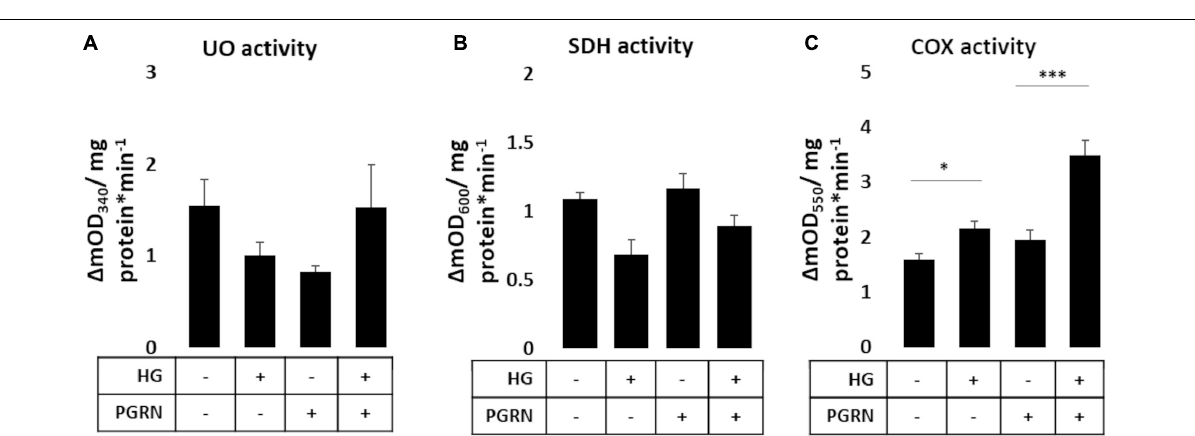
treatment from 1.000 ± 0.145 AU to 2.403 ± 0.381 AU ( p = 0.004 between control and HG + PGRN). However, high glucose and PGRN treatments alone did not elicit any change, only changing ERK1/2 phosphorylation to 1.342 ± 0.398 and 0.932 ± 0.241 AU, respectively ( p = 0.352 and 0.848, respectively). This effect appears to affect ERK2 ( F = 8.436, p =